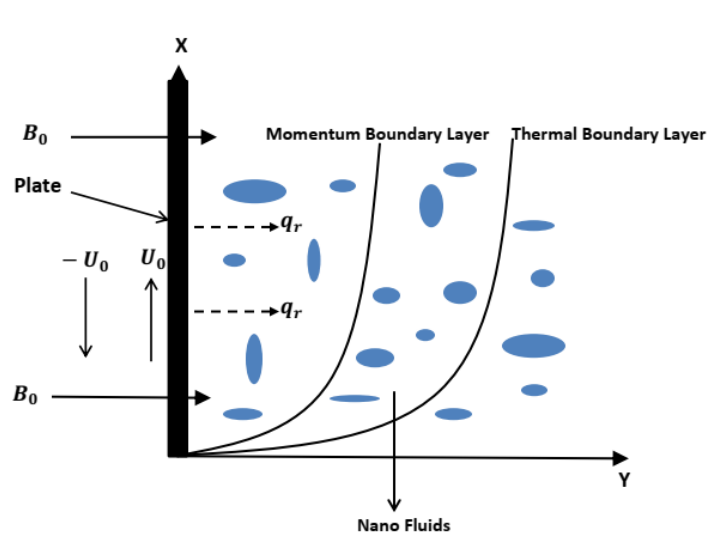
Figure 1. Presentation of